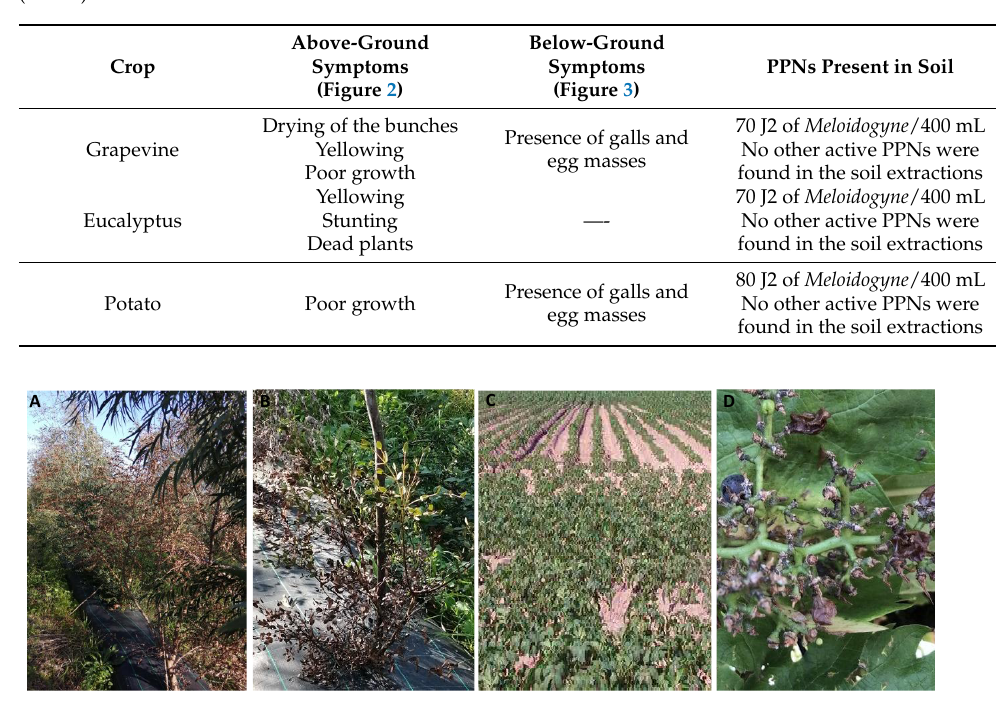
Figure 2. Above-ground symptoms of Meloidogyne hapla attack. ( A , B ): eucalyptus; ( C ): potato; ( D ): grapevine.